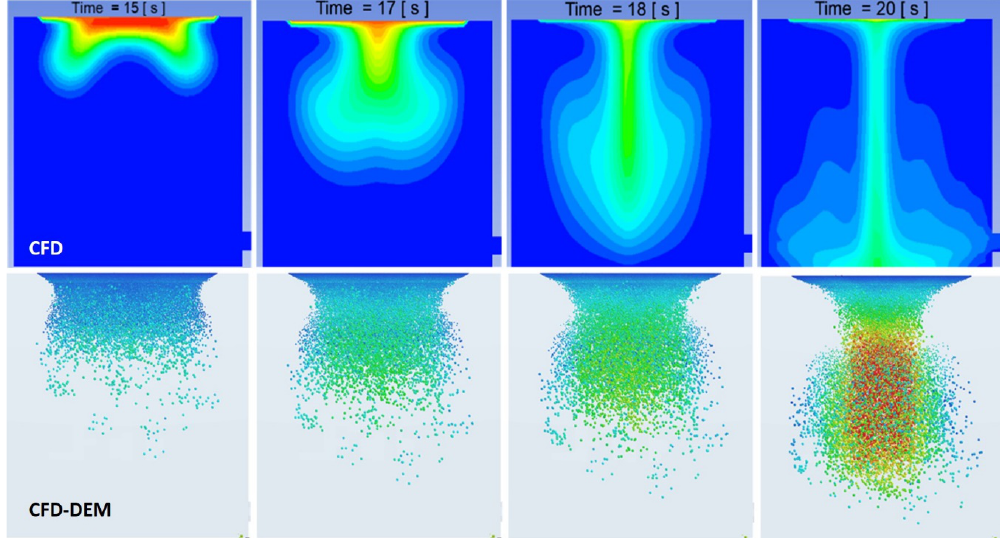
Figure 10. A comparison of the CFD and CFD–DEM results for matte settling in the small-scale settler model, revealing a similar funneling flow pattern at 15, 17, 18, and 20 s. Upper row: CFD, lower row: CFD–DEM.